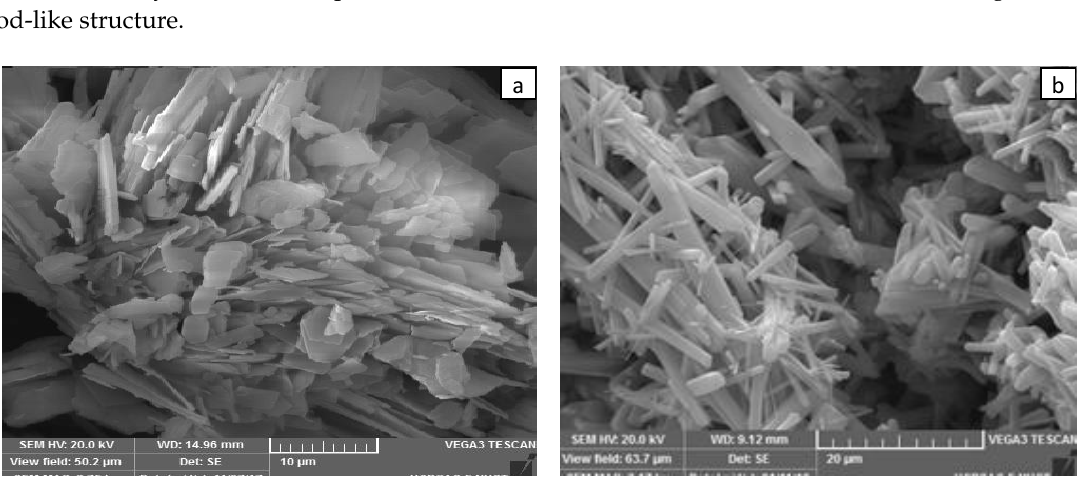
Figure 5. SEM images at 10 µm for ( a ) Cu-BDC MOF and at 20 µm for ( b ) Cu-BDC ⊃ HMTA MOF.